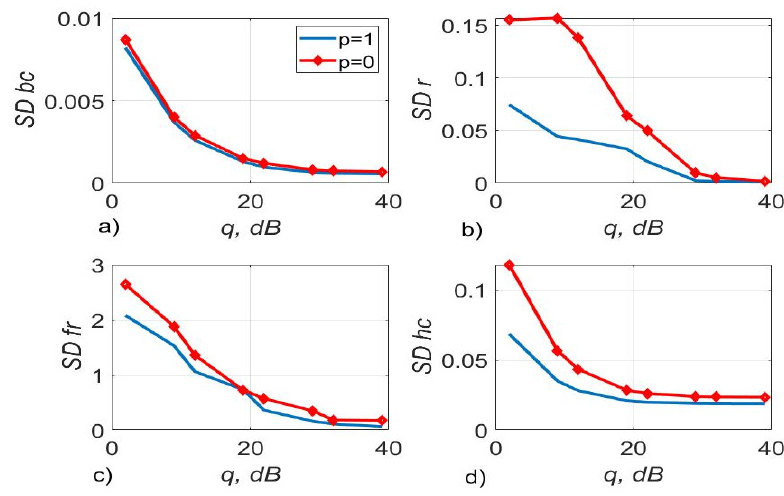
Figure 5. The SD of estimating DC offset (SD bc)—( a ), amplitude imbalance (SD r)—( b ), phase imbalance (SD fr) (deg)—( c ) and channel gains (SD hc)—( d ) versus SNR per bit, the test signal was modulated by 4-QAM and the algorithms, described by Equations (5)–(9) and (12) with p = 1, p = 0 was used.